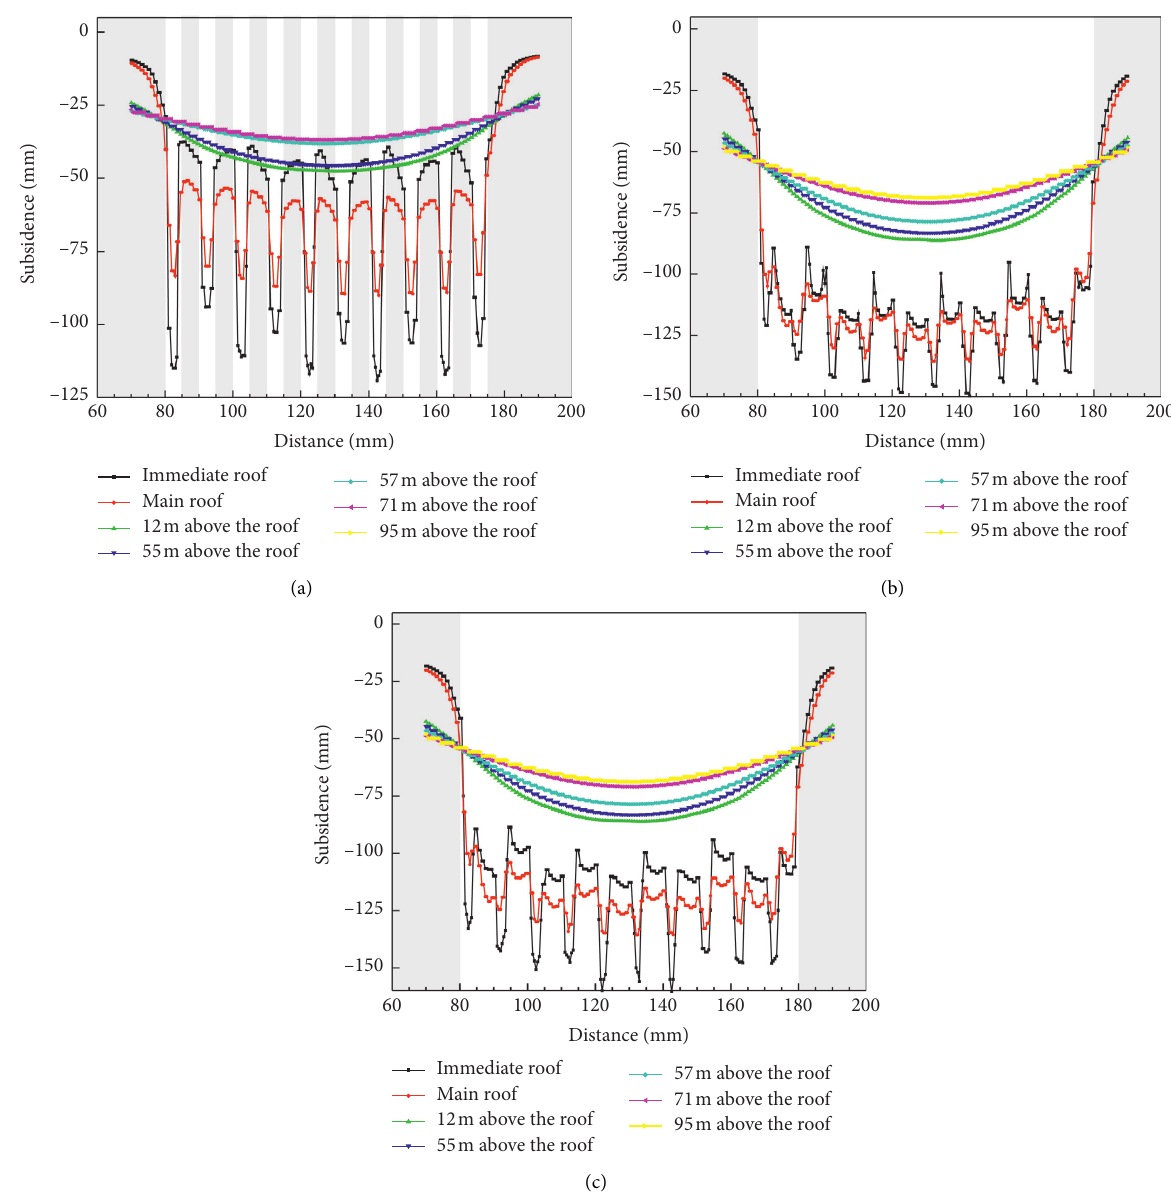
Figure 10: Roof sinking curve. (a) First stage. (b) Second stage. (c) Third